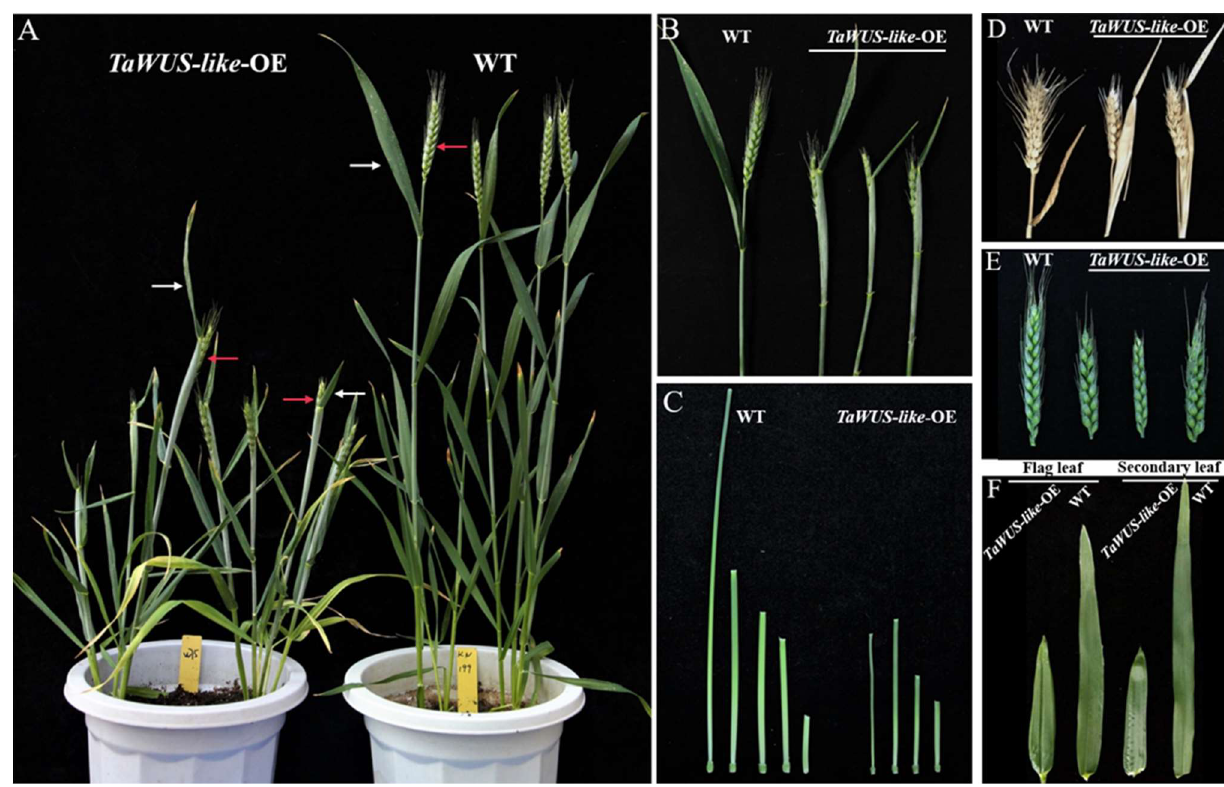
Figure 1. Phenotypes of TaWUS-like- OE lines and the WT in wheat at heading stage: ( A ) Lines or plants. The white and red arrows indicate the flag leaf (OE/WT) and the spike (WT)/sheathed spike (OE), respectively. ( B ) Sheathed spike. ( C ) Length of internodes, including uppermost, secondary, third, fourth, fifth from left to right). ( D ) Sheathed spike at mature stage. ( E ) Spike length. ( F ) Flag and secondary leaf.